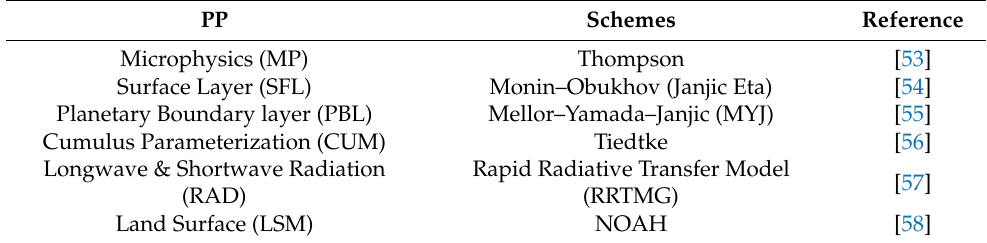
Table 1. Configuration of the Physics Parameterizations (PP) schemes for the WRF-ARW